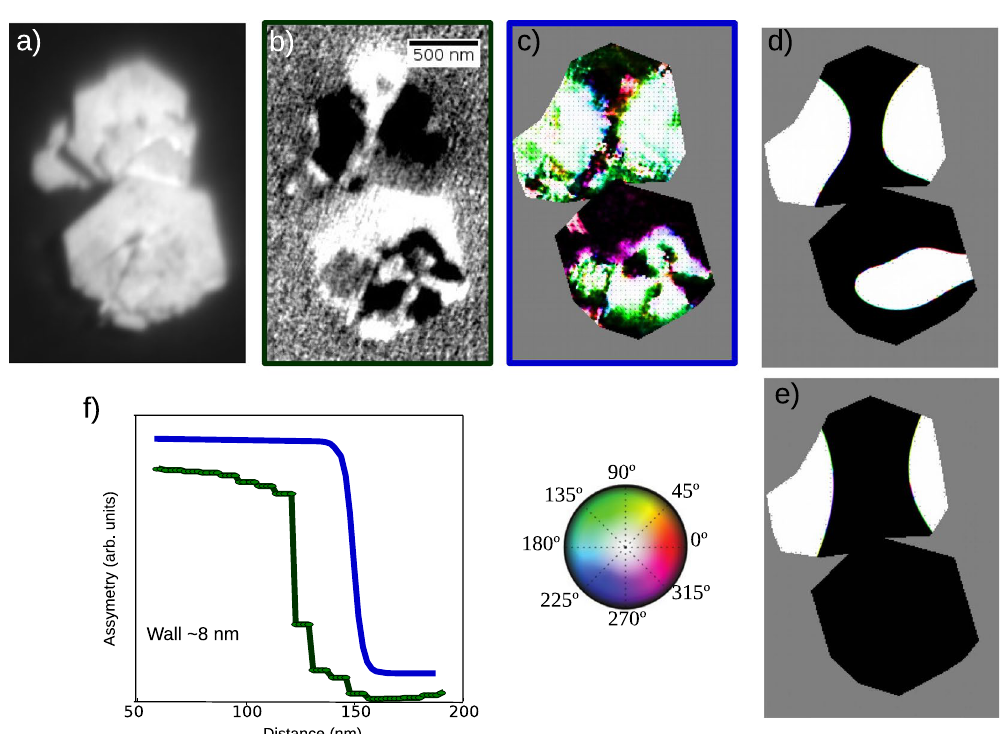
Figure 10. ( a , b ) XAS and XMCD images, respectively. ( c ) Magnetization vector in the platelets pixel by pixel. ( d ) Relaxed initial configuration calculated considering literature parameters for this compound, ( e ) Relaxed initial configuration using in the simulation experimental values and ( f ) comparison between domains wall width of the experiment and